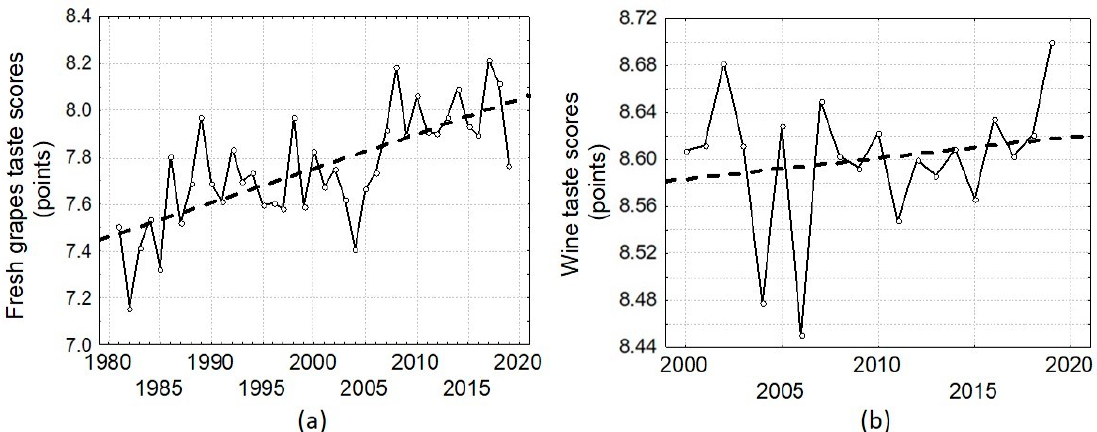
Figure 3. Dynamics of the average taste scores of ( a ) fresh grapes, ( b ) wine. Designations: solid line – actual data; dotted line—calculated linear trend.